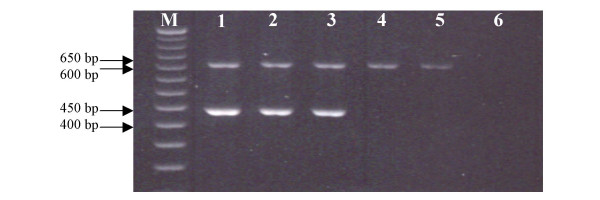
DMBT1 expression assessed by RT-PCR. Both DMBT1 (435 bp) and β-2microglobulin (602 bp) products were loaded in the same well. Lane M: size marker (50 bp ladder), lane 1: cell line Hs 578T, lanes 2, 3, 4, 5: breast carcinomas, lane 6: negative control without template.